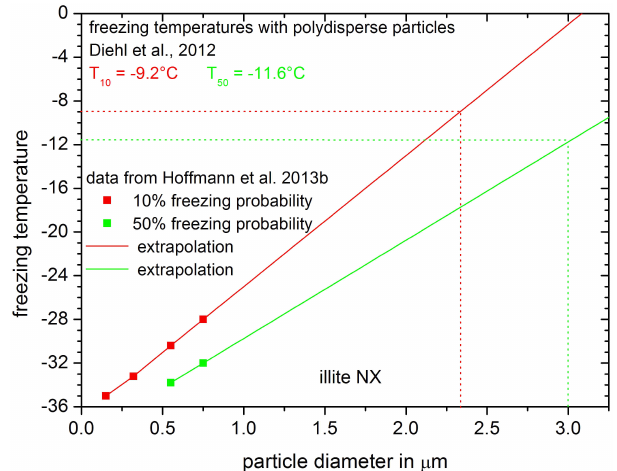
Figure 3. Freezing temperatures as a function of particle diameter for illite NX in the contact mode. Extrapolations to larger particle sizes.